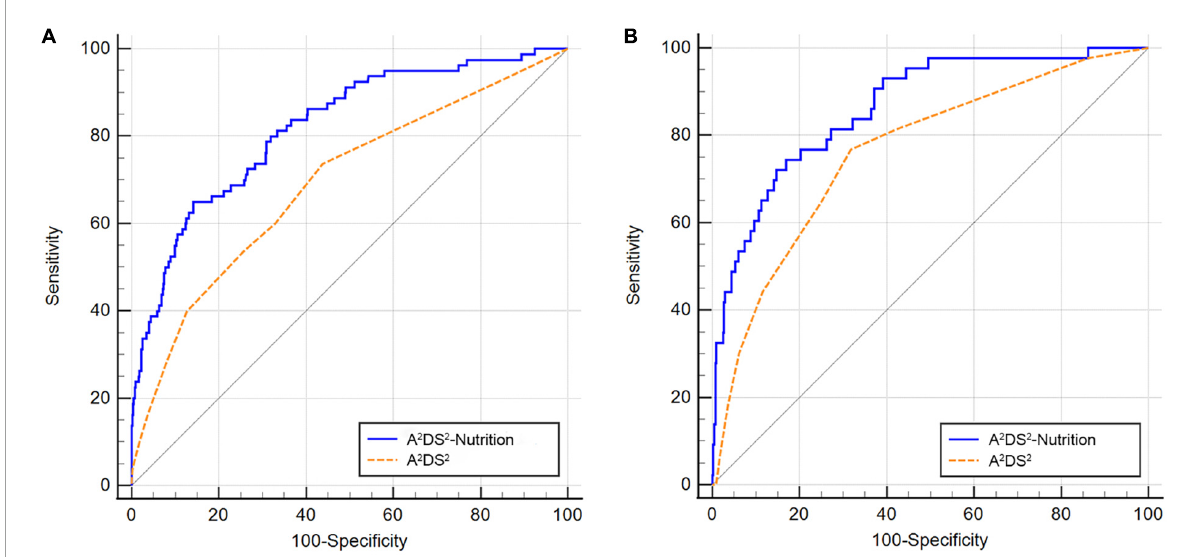
FIGURE4 Comparison of the AUROC values between the A 2 DS 2 -Nutrition and A 2 DS 2 score. (A) In the training group, the A 2 DS 2 -Nutrition had a larger AUROC than the A 2 DS 2 [0.820 (95% CI, 0.794–0.845) vs. 0.691 (95% CI, 0.660–0.722), P < 0.001]; (B) In the validation group, the AUROC of